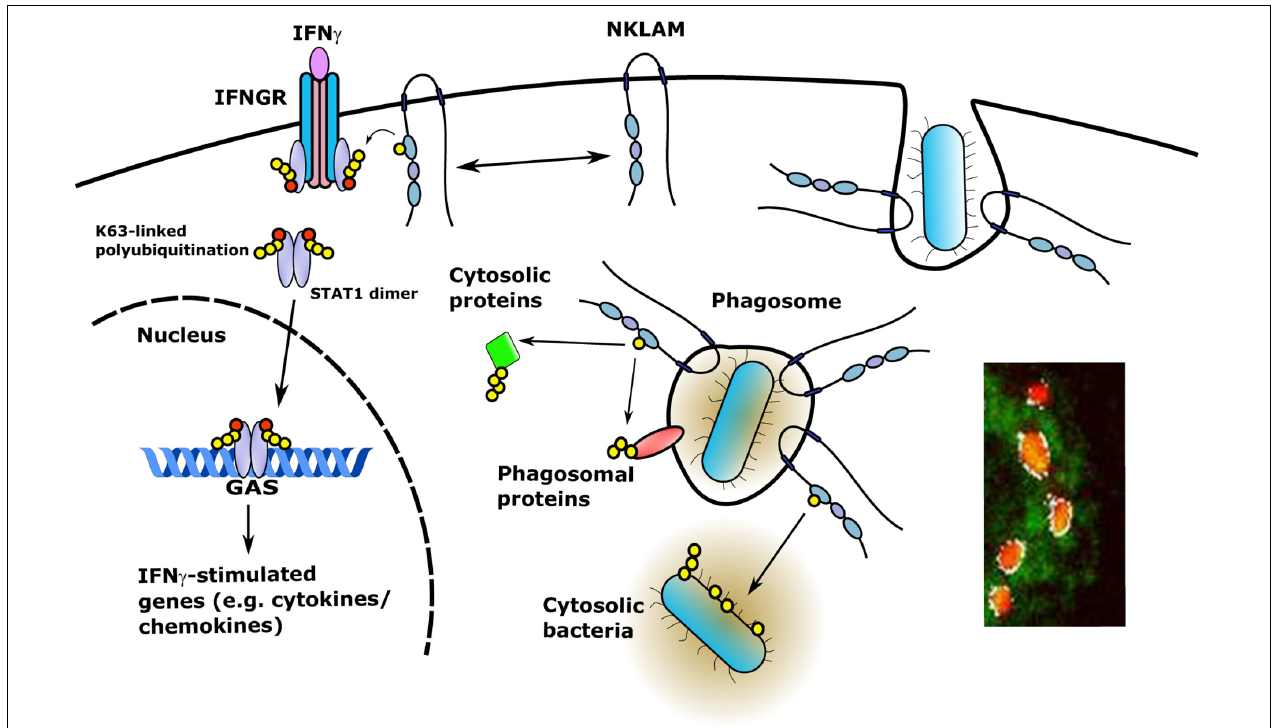
FIGURE 4 | NKLAM in macrophage immune function. Upon exposure to IFN γ , STAT1 is phosphorylated and NKLAM is transiently associated with the IFN γ -IFNGR complex at the plasma membrane. In this location, NKLAM is in close proximity to STAT1, which would allow NKLAM to ubiquitinate STAT1 or other proteins to promote STAT1 transcriptional activity. After ingestion of bacterial targets, NKLAM is localized to the phagosome membrane with the catalytic RING2 domain and C-terminal tail facing the cytoplasm. This would provide NKLAM with access to phagosome membrane proteins and cytosolic target proteins, as well as bacteria that escape the phagosome. Red circles; phosphotyrosine, yellow circles; ubiquitin. Immunomicrograph insert: Macrophage phagosomes after ingestion of fluorescent-labeled E. coli (red). NKLAM staining: green; Image J-defined co-localization of E. coli and NKLAM: white. Adapted from Lawrence, D.W., and Kornbluth, J. E3 ubiquitin ligase NKLAM is a macrophage phagosome protein and plays a role in bacterial killing. Copyright 2012, with permission from Elsevier and Lawrence D.W., and Kornbluth, J. E3 ubiquitin ligase NKLAM ubiquitinates STAT1 and positively regulates STAT1-mediated transcriptional activity. Copyright 2016, with permission from